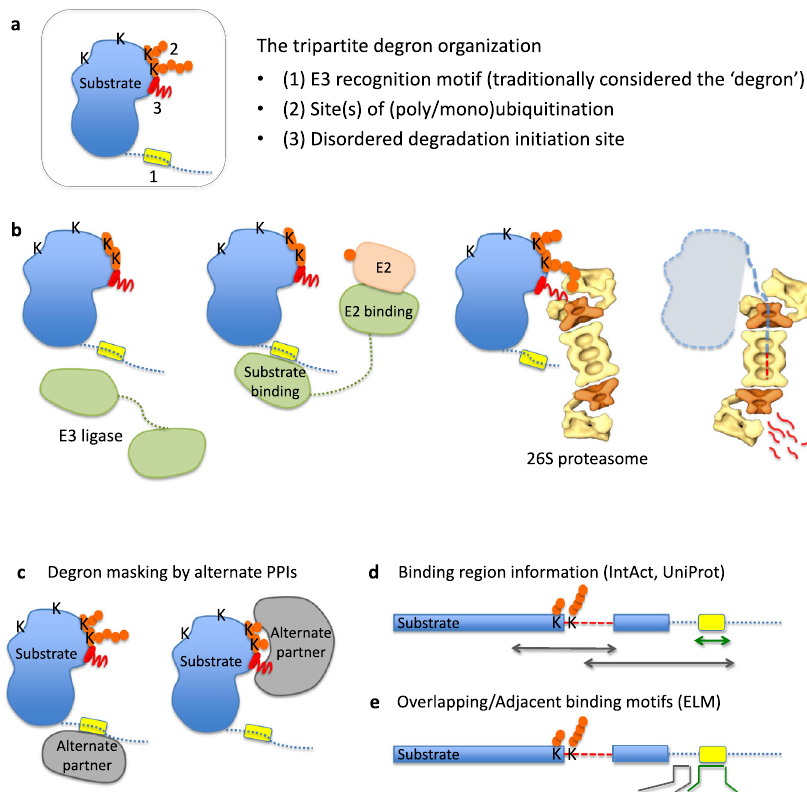
Fig. 1 Schematic of tripartite degrons and their masking by PPIs. a Tripartite degron organization, and, ( b) schematic overview of how each of the degron components mediates speci fi c steps in substrate selection and degradation in the UPS (adapted from Guharoy et al. 14 ). Firstly, E3 ligases target speci fi c substrates via primary degrons, followed by ubiquitination of single (or multiple, neighboring) lysines, K, by complexes consisting of E3 ligase and appropriate E2 conjugating enzyme(s). Ub-tagged substrates are then targeted to the 26 S proteasome for degradation. Tertiary degrons (located within or near Ubsites) are IDRs that initiate substrate unfolding and entry into the proteasomal core. c Alternate partners, APs, can bind to substrate segments harboring degron element(s), masking them from the UPS machinery. Binding site data analyzed in this study were obtained from ( d ) IntAct 24 , UniProtKB 33 , and ( e ) motif data from the Eukaryotic Linear Motif (ELM) resource 35